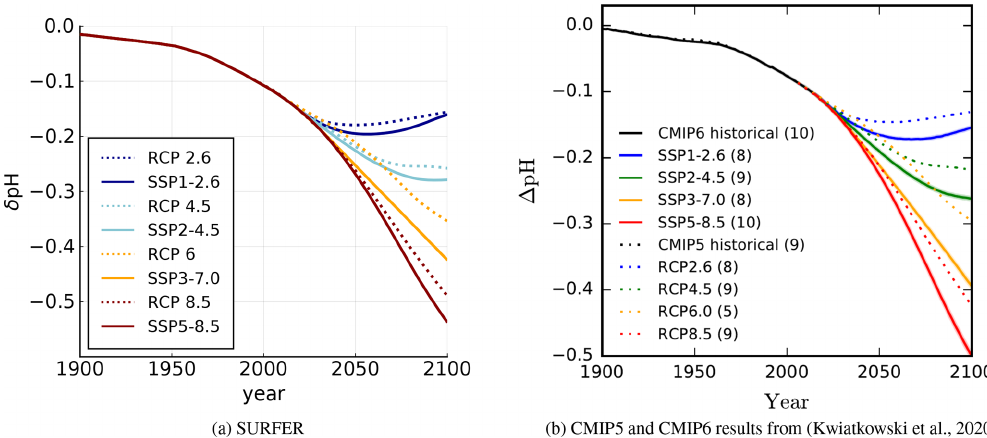
Figure 13. Change in pH in the upper ocean layer under RCPs and SSPs emission scenarios.